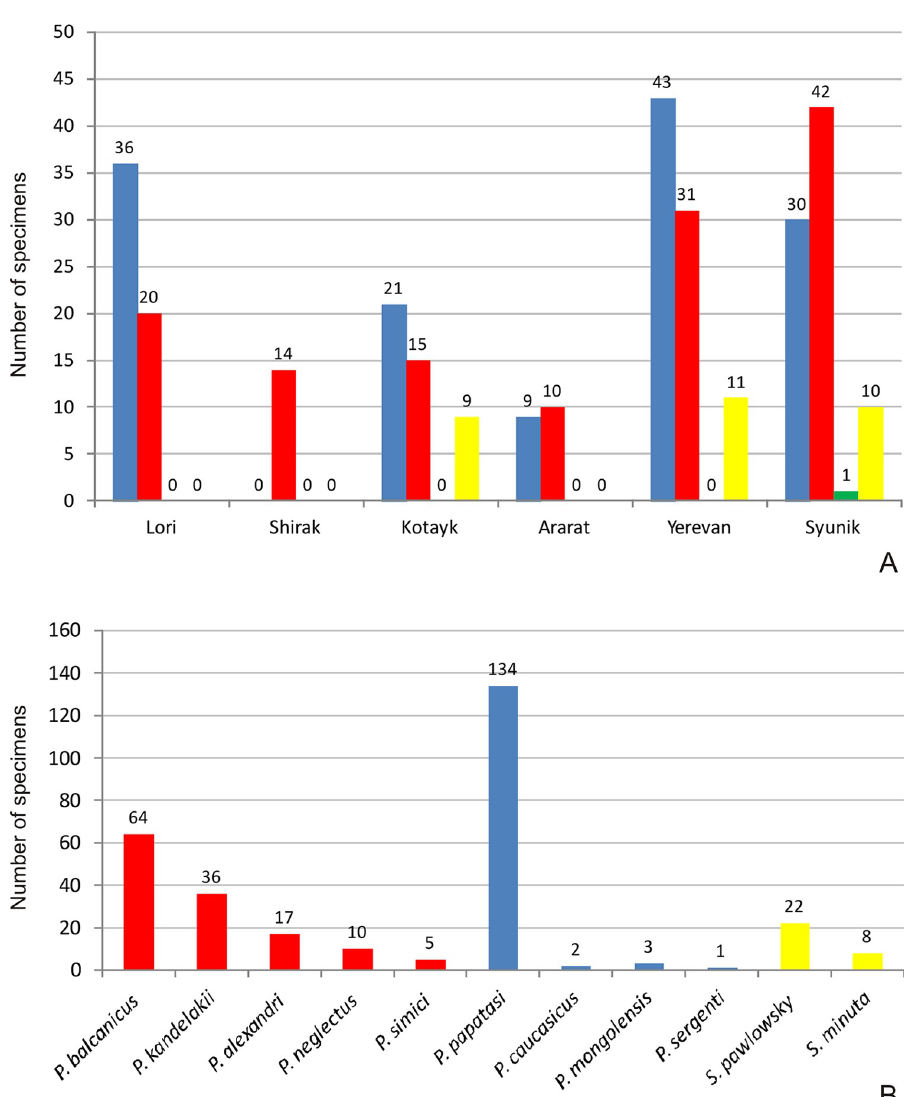
Fig 6. Diversity of sand fly species in Armenia observed during the vector surveys in active foci of visceral leishmaniasis. The surveys were conducted in six districts of Armenia in 2009–2015. The number of proven and potential vectors of L . infantum (red), L . major (blue), L . tropica (green) and Sauroleishmania (yellow) in the six districts is shown in (A). Eleven distinct sand fly species were collected. The numbers per species are shown in (B). Only two ( P . balcanicus and P . kandelakii ) are proven vectors of VL in the Southern Caucasus, three are potential vectors of L . infantum (red). P . papatasi , P . caucasicus (and P . mongolensis as morphotype of P . caucasicus ) (blue) are proven vectors for zoonotic CL ( L . major ) in Central Asia, however L . major is absent in the Southern Caucasus. P . sergenti (green) is the potential vector for anthroponotic CL ( L . tropica) in the Southern Caucasus. The two species of the subgenus Sergentomyia (yellow) are transmitting only Sauroleishmania